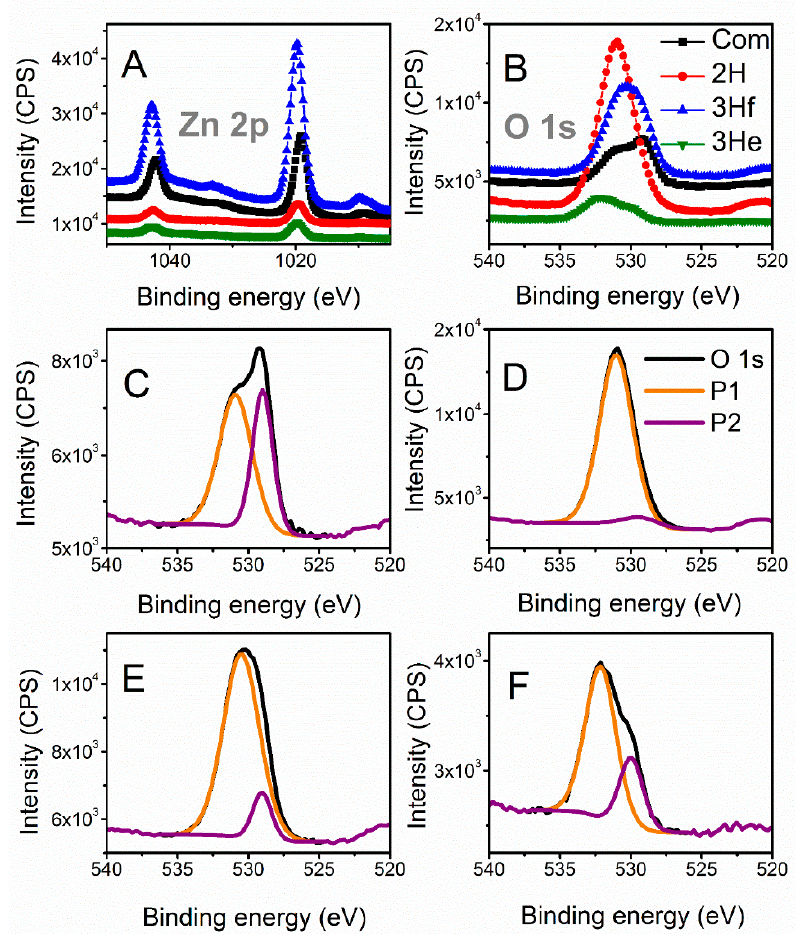
Figure 4. X-ray photoelectron spectroscopy of Zn 2p ( A ) and O 1s ( B ) narrow scans; deconvolution of O 1s signals for commercial ZnO ( C ), 2H trials ( D ), 3H filtered ( E ) and 3H evaporated sample ( F ). O 1s (C–F) signals were resolved into two peaks (P1 and P2) related to O 2 − ions in the normal ZnO lattice and to the O 2 − ions in the oxygen-deficient regions, respectively.